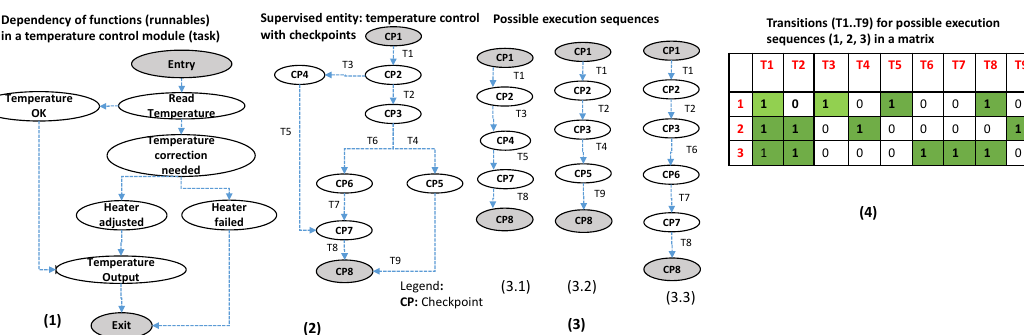
Figure 7. Program flow monitoring configuration of a temperature control module ( 1 ): Functions (runnables) in this module (task), ( 2 ): Possible checkpoints of the supervised entity and ( 3 ): Possible execution sequences of the supervised entity and ( 4 ): Dependencies of functions/CPs-denoted by transitions among them; for possible (correct) execution